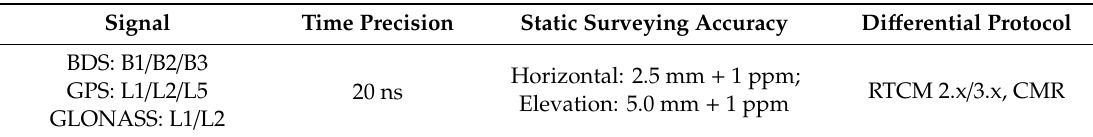
Table 1. The parameters of UB380 board